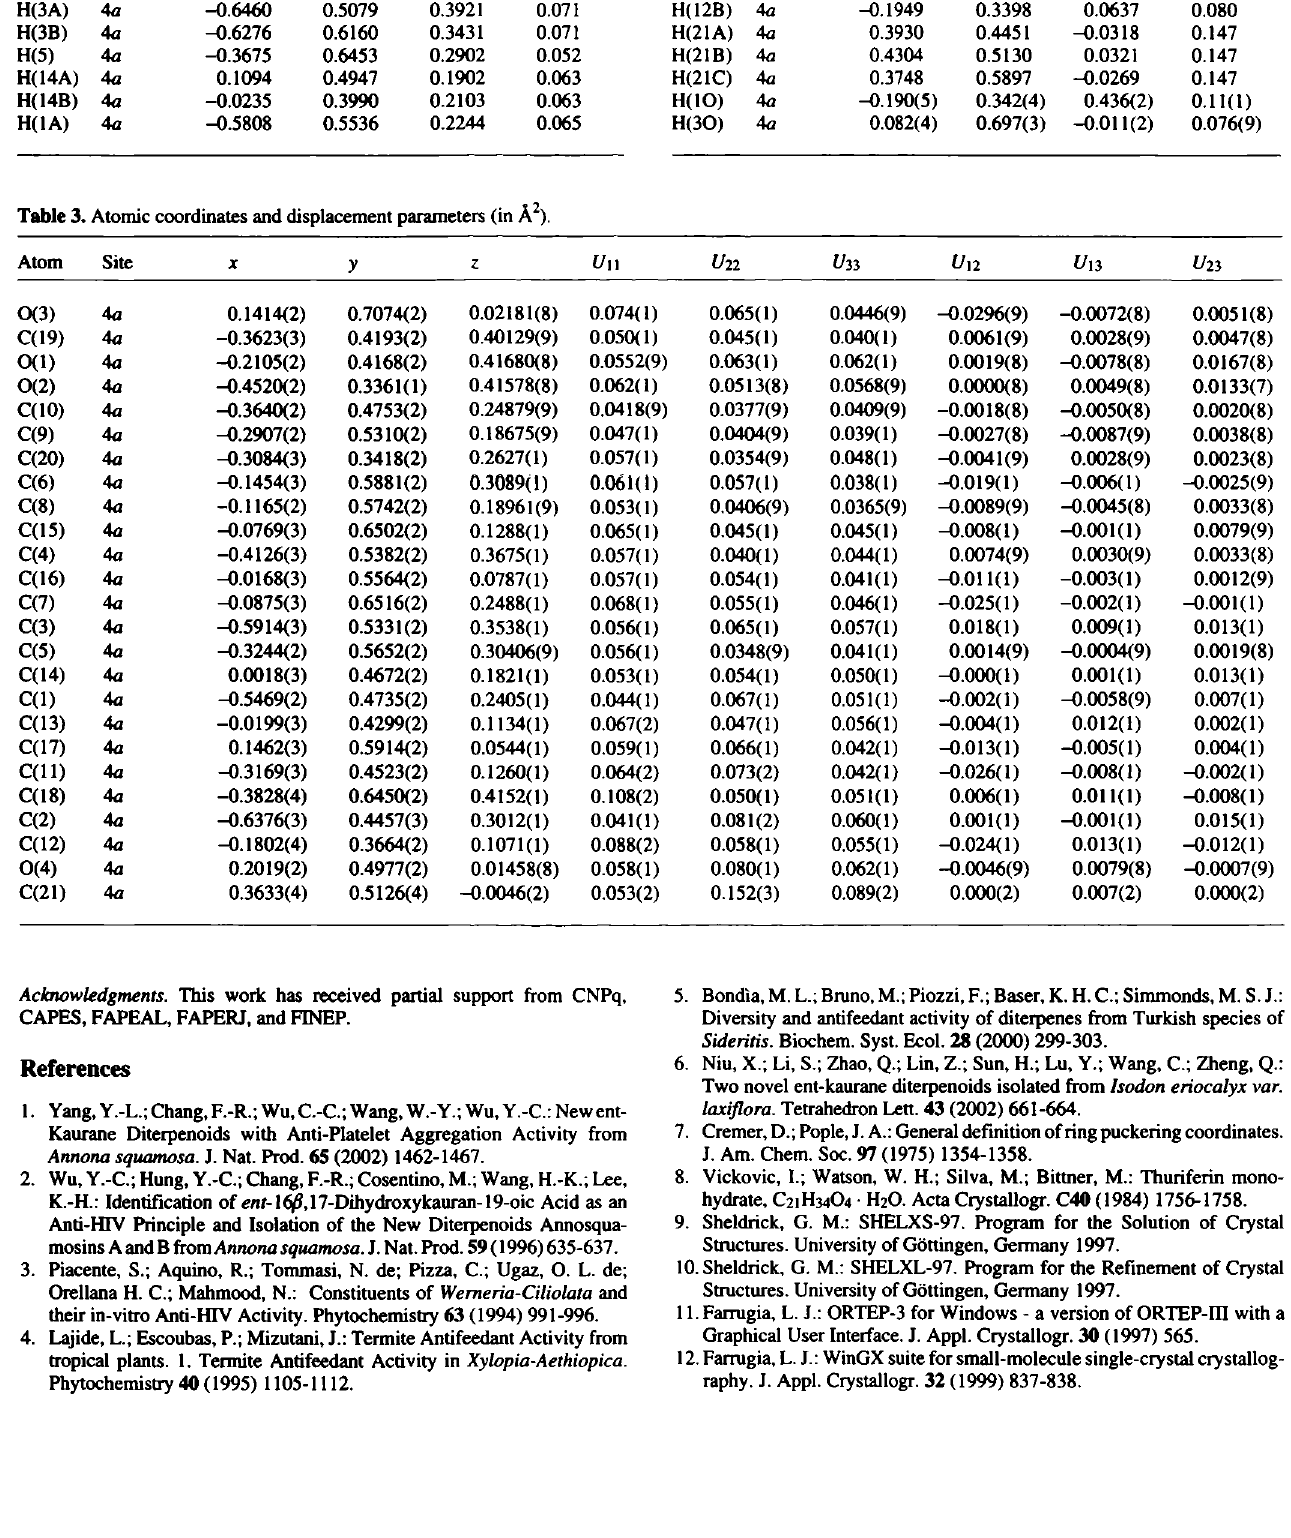
Table 3. Atomic coordinates and displacement parameters (in Â 2